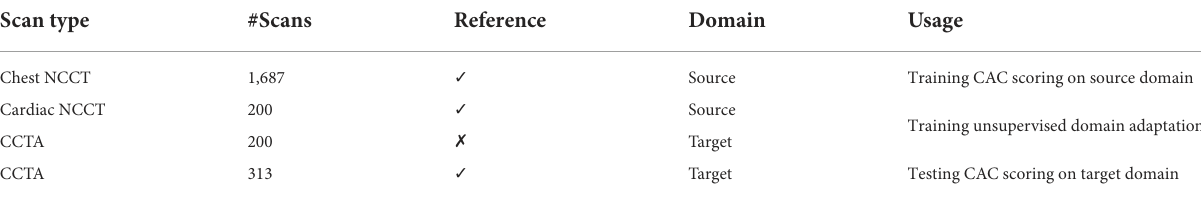
TABLE 1 Description of data and corresponding usage. Scan